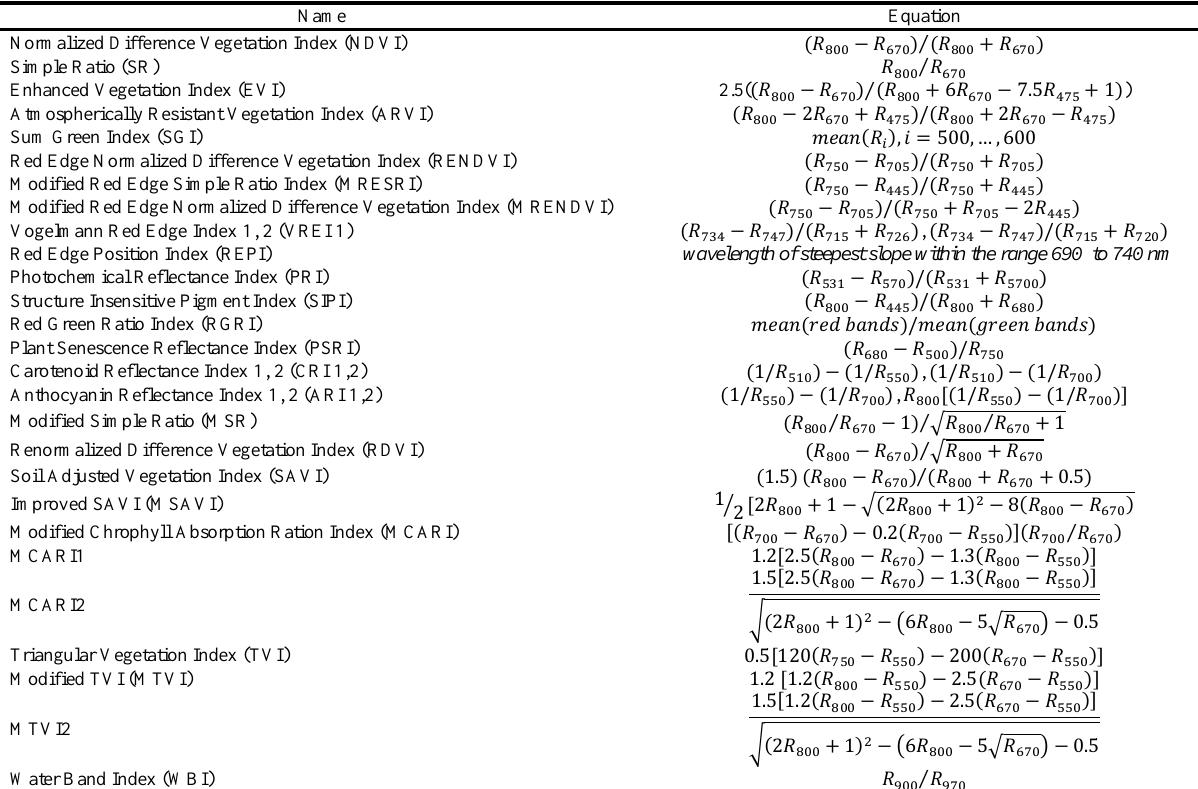
Table 1. Spectral indices from hyperspectral image, R x is the reflectance at x